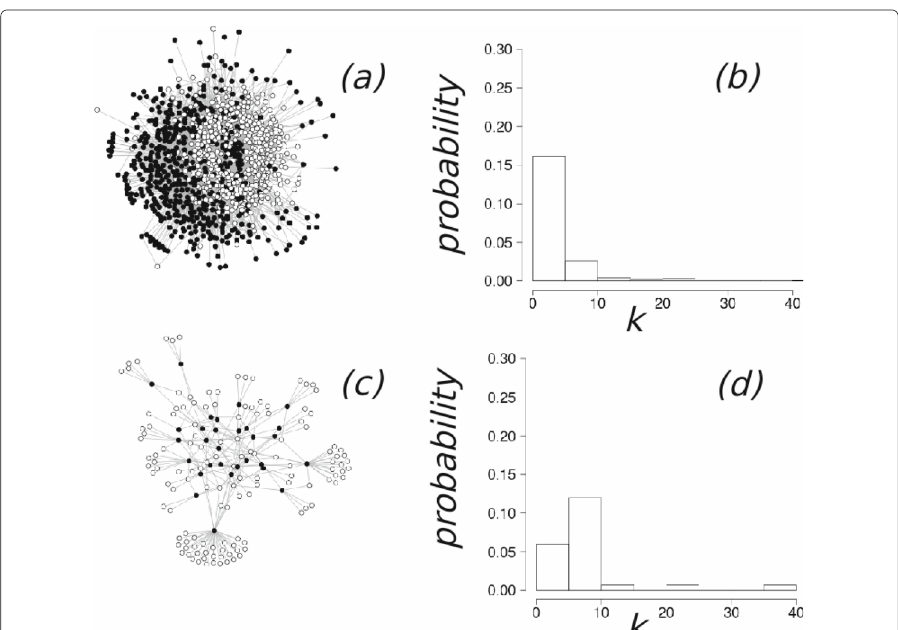
Fig. A.1 Realization of a system with N = 1000 agents, and Barabasi-Albert contact network of mean degree < k > = 12. Figures correspond to two values of the parameter ρ . Up: early times ρ = 0.49; Down: times close to convergence ρ = 0.07. Left panel a , c : snapshots of G AL . Right panel b , d : degree distribution of the corresponding graph G AL